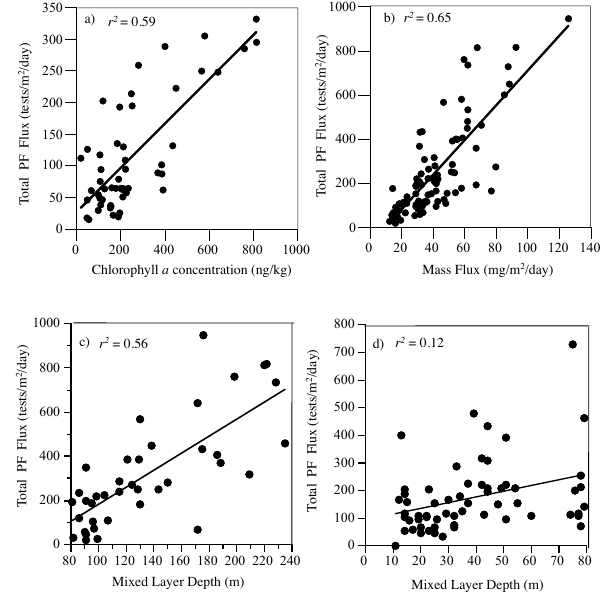
Figure 4. Correlation between total planktonic foraminifera flux in the 1500m OFP trap (thin, black line) with environmental param- eters measured at the BATS site. (a) Chlorophyll a concentration at 0–25m. The correlation excludes an anomalous peak in chloro- phyll a concentration observed in 2010. (b) Regression with mass flux (c) MLDs>80m, excluding the extremely deep MLD observed in 2010. (d) MLDs<80m.